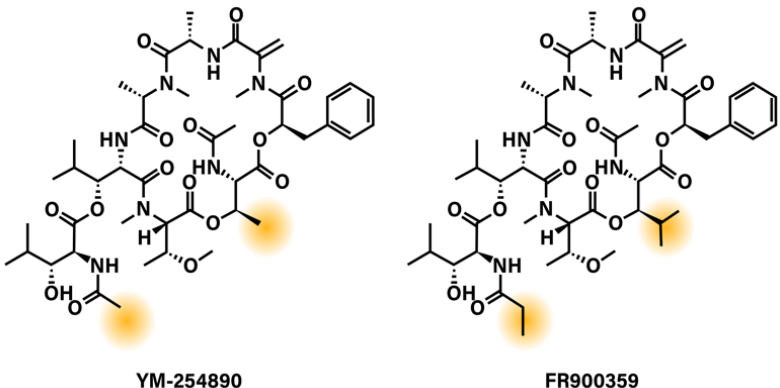
Figure 2. Chemical structures of G q/11 depsipeptide inhibitors YM-254890 and FR900359. High- lighted areas show the regions of YM-254890 and FR900359 that differ.